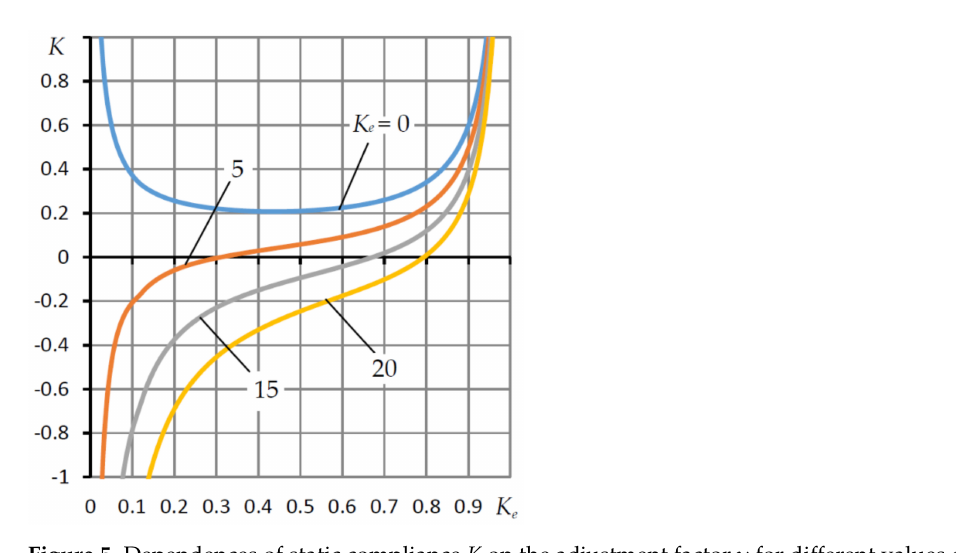
Figure 5. Dependences of static compliance K on the adjustment factor χ for different values of the coefficient of elasticity K e .